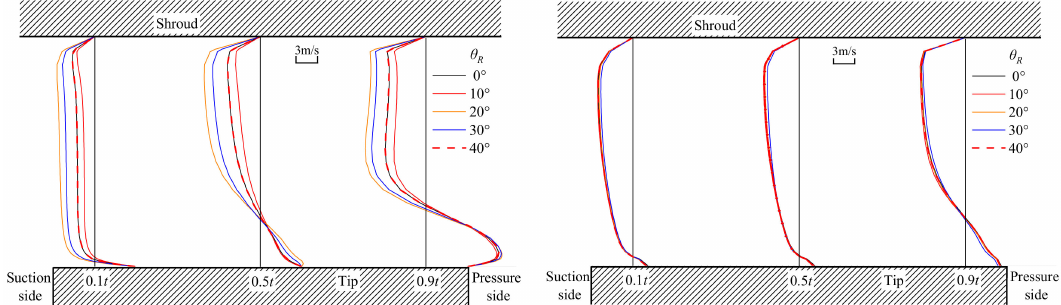
Figure 14. In-plane absolute velocity profiles in the tip clearance at 10% ( left ) and 50% ( right ) chord length. The velocity profiles shown at five instantaneous positions of the rotor θ R cover the angular spacing between adjacent stator blades. From suction side to pressure side, three sections are taken at 10%, 50% and 90% of the local thickness t , respectively. The velocity magnitude is zero at the vertical straight lines. The shroud is stationary. The rotor tip rotates from left to right. Q = 0.42 m 3